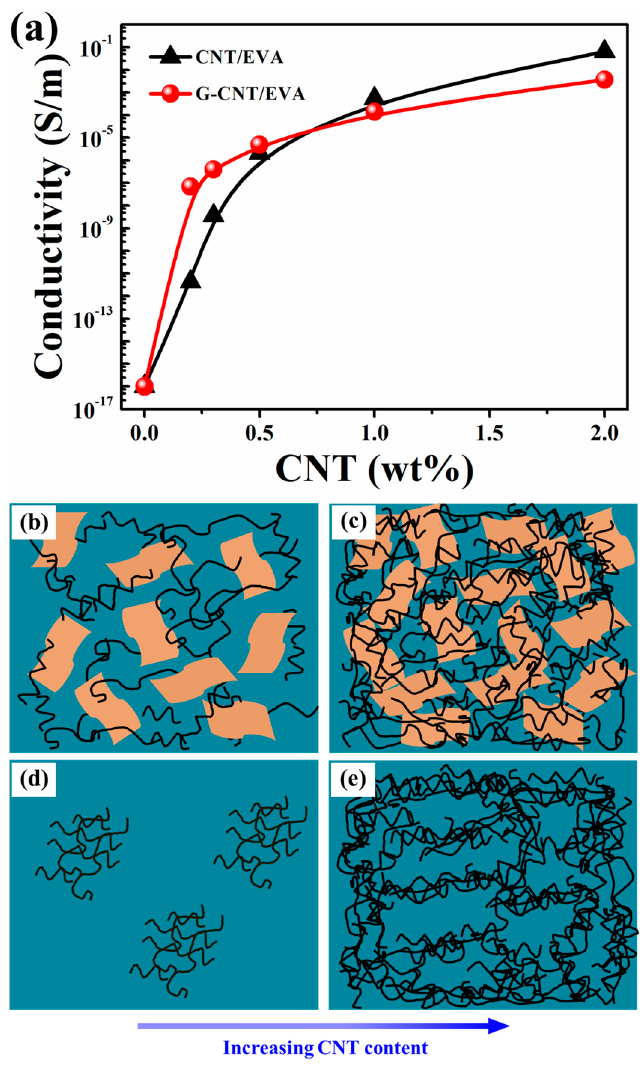
Figure 5. ( a ) Electrical conductivities of the G–CNT/EVA and the CNT/EVA composites. ( b ) and ( c ) The scheme of the conductive networks in the G–CNT/EVA composites at low and high CNT contents, respectively. ( d ) and ( e ) The scheme of the conductive networks in the CNT/EVA composites at low and high CNT contents, respectively.